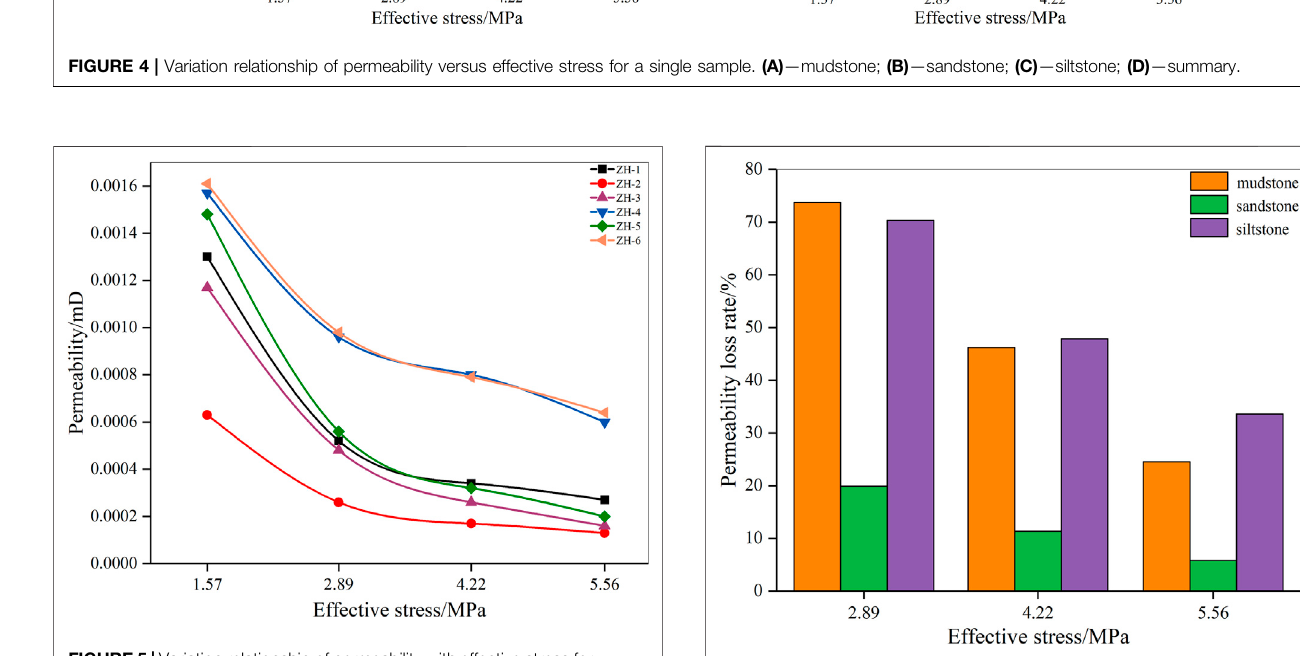
FIGURE 5 | Variation relationship of permeability with effective stress for different surrounding rock FIGURE 6 | Variation of permeability damage rate with effective stress.